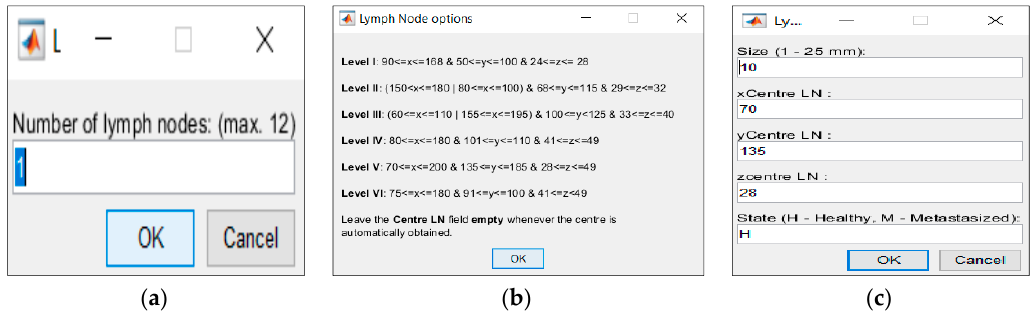
Figure 7. Interfaces created to modified CLNs. ( a ) Interface which allows the user to choose the number of CLNs to insert in the phantom. ( b ) Informative note which specifies the limits of the six levels of the CLNs. ( c ) Interface which allows the user to choose the size, location and medical state of each CLN.